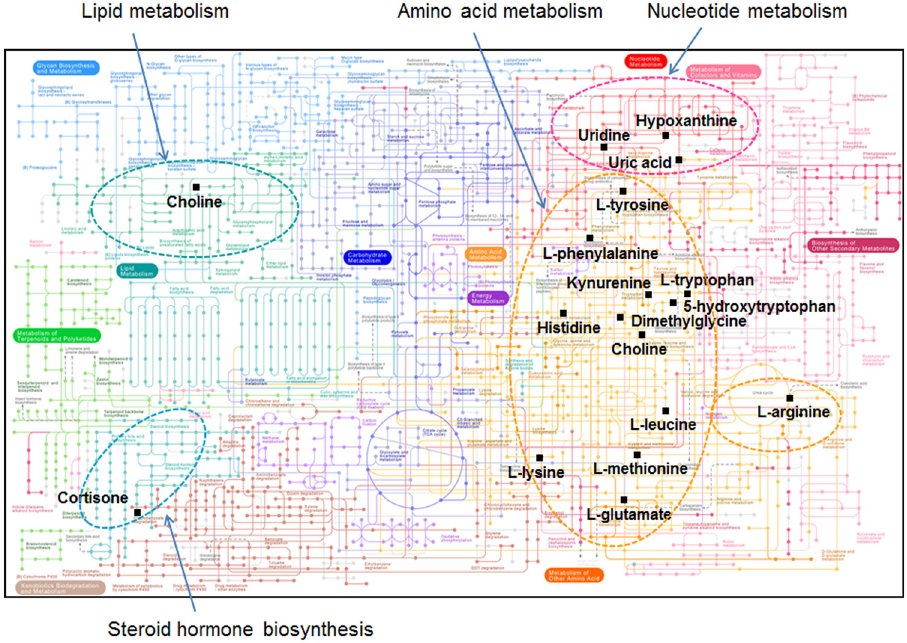
Fig 6. Visualization of metabolic pathways in marmosets that differed from ranges for human values in HMDB. Quantitatively different metabolites were visualized in the KEGG metabolic pathways. (http://www. genome.jp/kegg/pathway.html#metabolism). Black squares indicate quantitatively different metabolites matched in the metabolic pathways including lipid metabolism, amino acid metabolism, nucleotide metabolism and steroid hormone